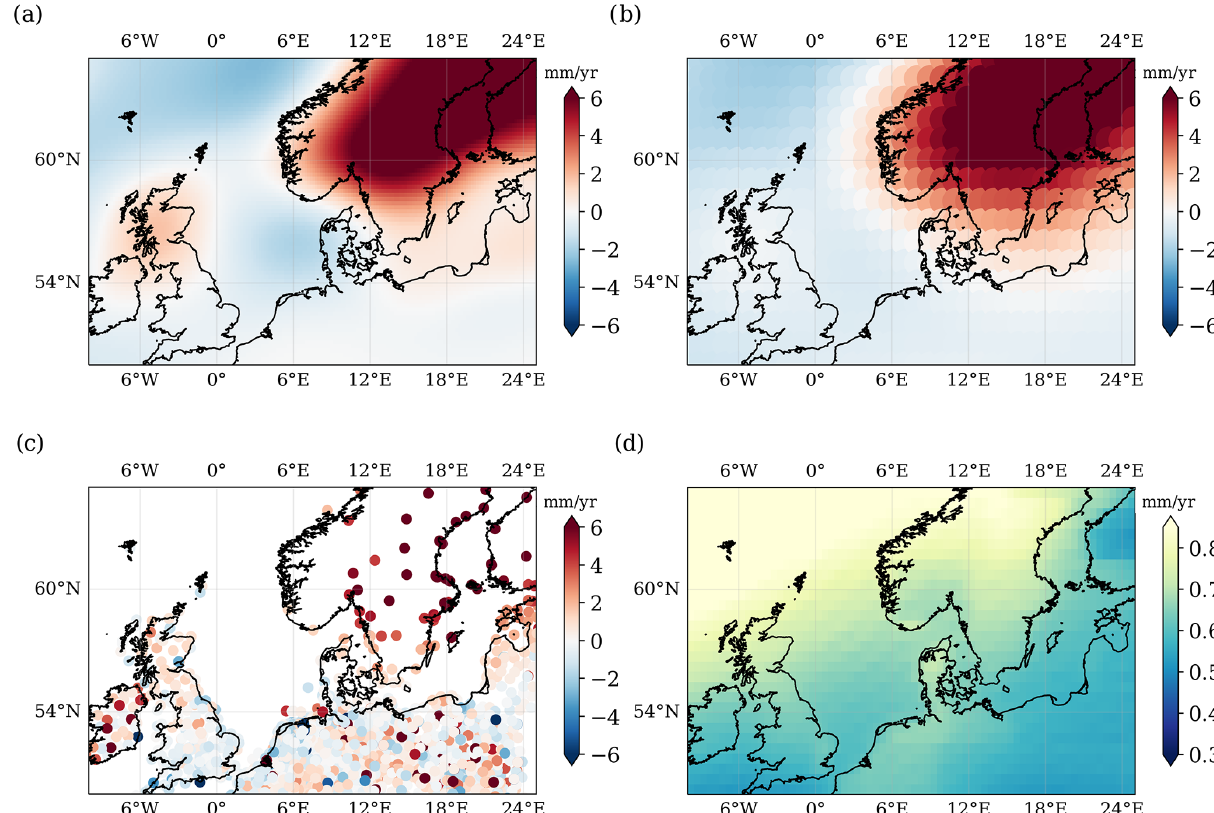
Figure 2. VLM estimates used to correct relative sea level trends from TGs. GIA trends from (a) ICE-6G D (VM5a) and (b) Caron et al. (2018). (c) GPS trend from the NGL solution. (d) Trend caused by contemporary mass redistribution over the period 1995–2019. Note that the scale of (d) is much smaller than in the other